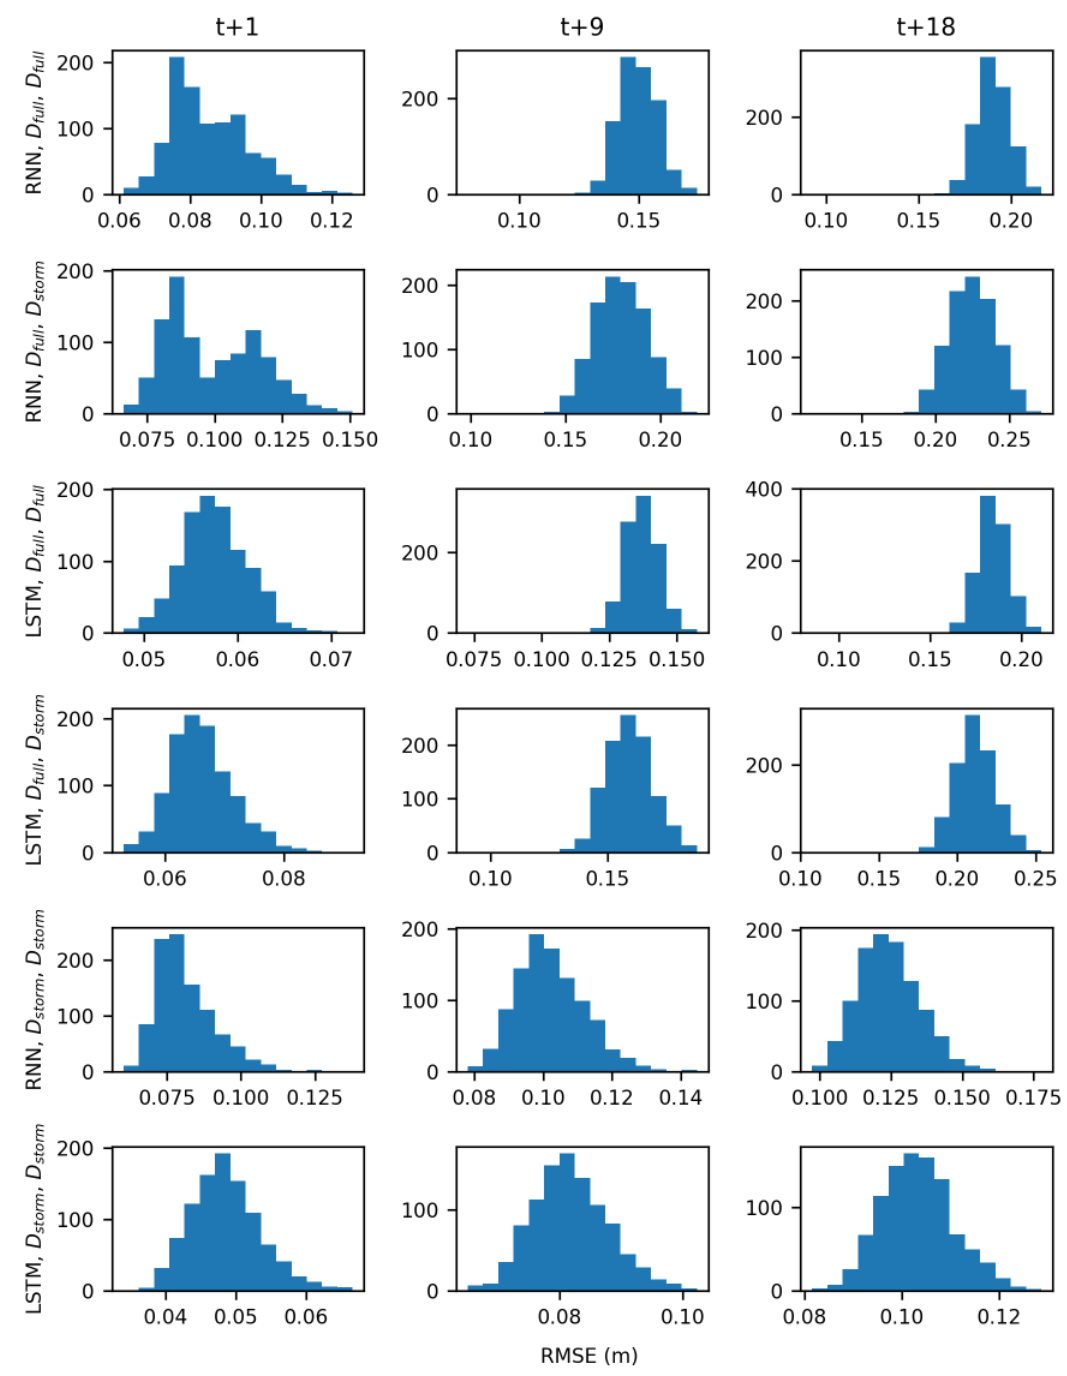
Figure A2. RMSE distributions for GW2 using observed data. Columns represent the forecast horizons t + 1, t + 9, and t + 18. Rows are specified as model type, training data, and testing data.